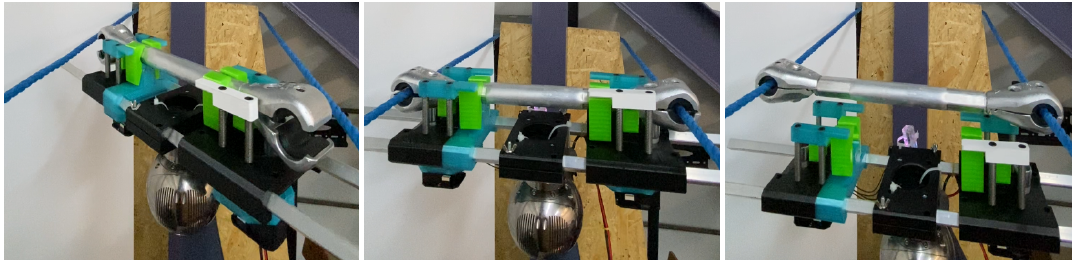
Figure 4. End effector for electrical spacers